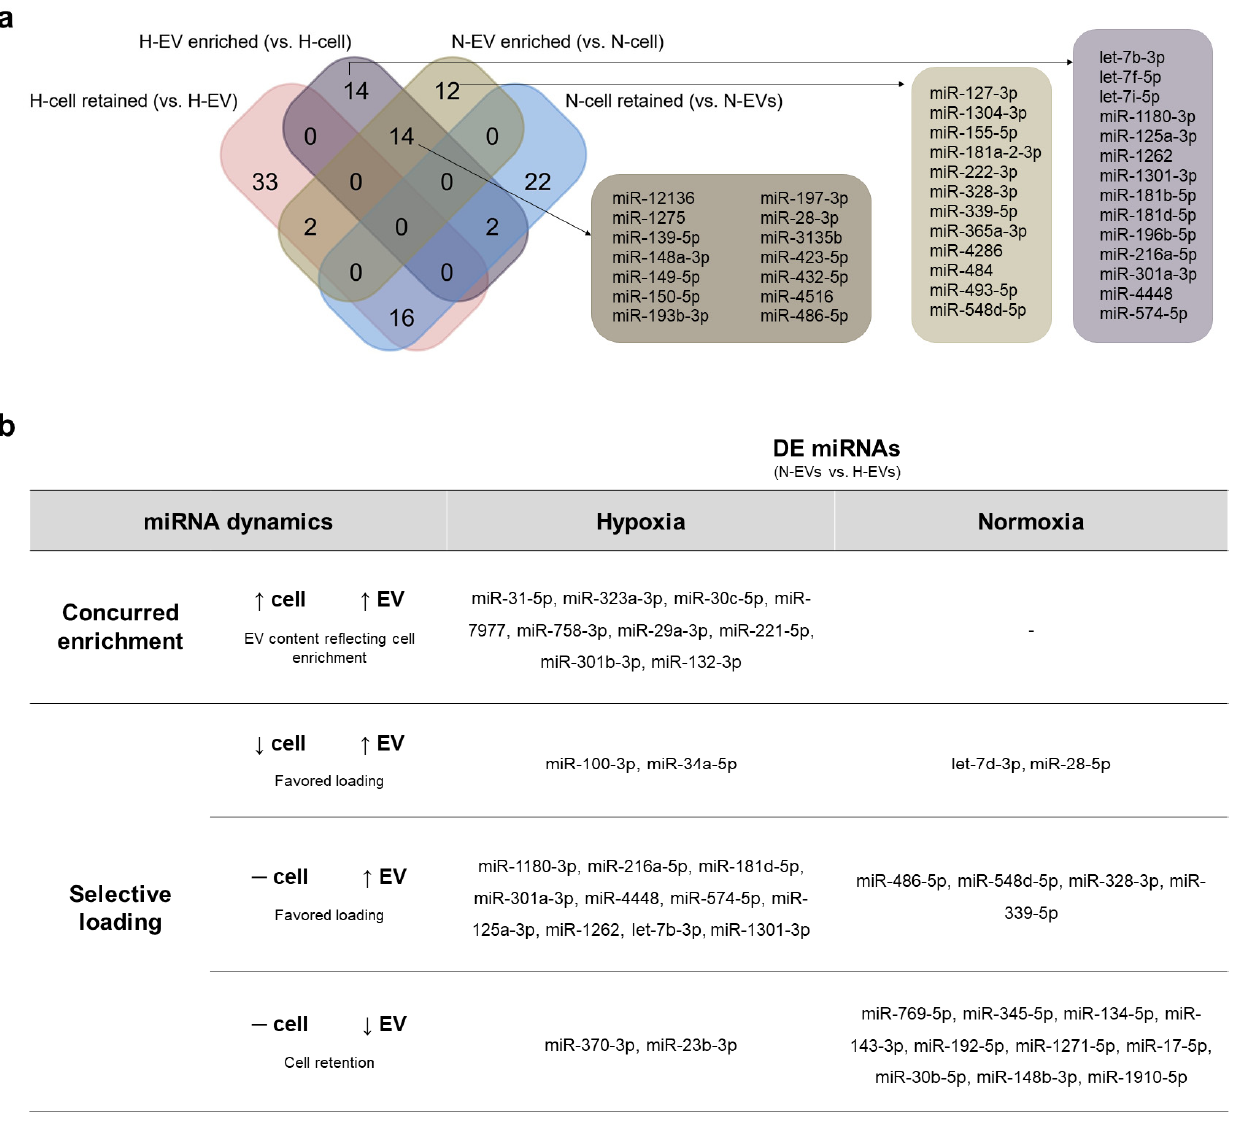
Figure 3. Analysis of miRNAs enriched in E-CD133 EVs or retained in E-CD133. ( a ) Venn chart analysis of the miRNAs found as enriched in the EVs or retained in the cells during hypoxia and normoxia. ( b ) Analysis of the miRNA dynamics that may lead to a DE of miRNAs in H-EVs vs. N-EVs (up arrow = augmentation in miRNA expression/enrichment; down arrow = reduction in miRNA expression/enrichment; dash = no change in miRNA expression/enrichment).